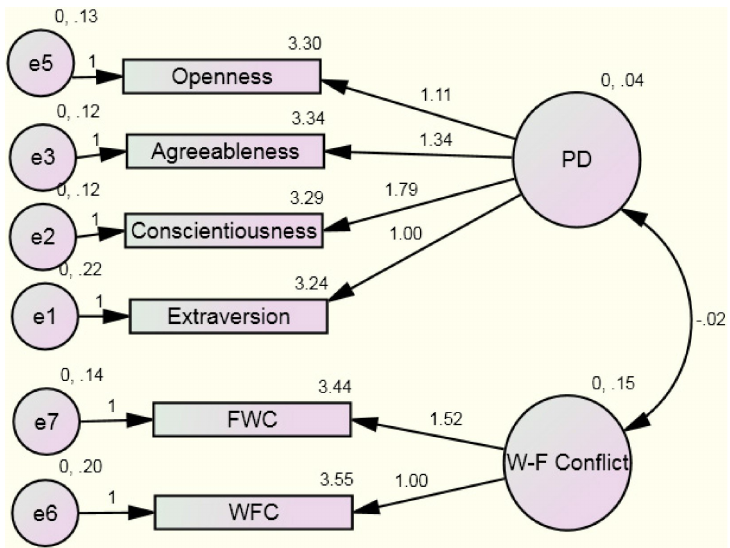
Figure 3. Showing the estimates extracted by running Confirmatory Factor Analysis (CFA) on re-hypothesised